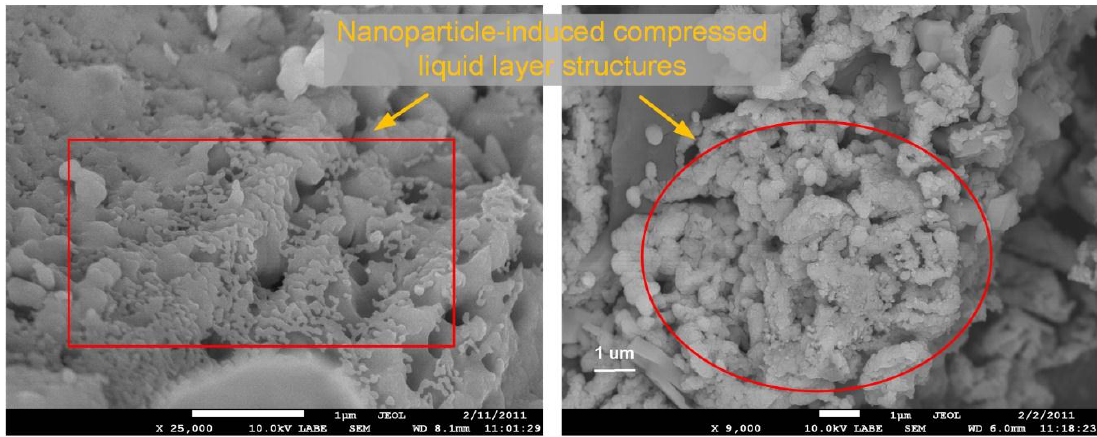
Figure 9. SEM images of the nanofluid (1 wt % nanoparticle and 5 wt % GA): nanoparticle-induced compressed liquid layer structures in solid phase.